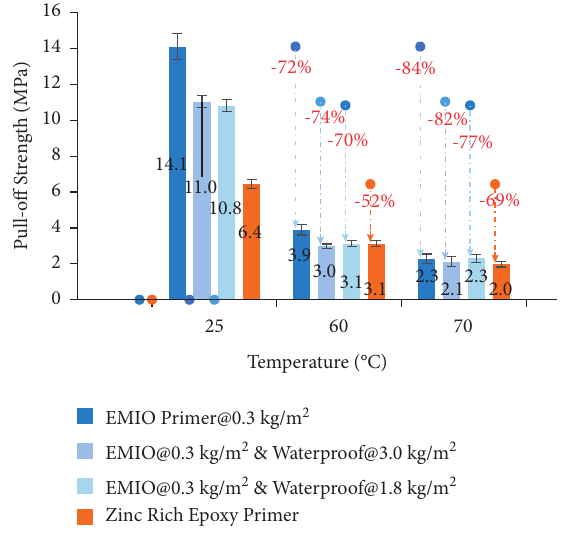
Figure 3: Pull-off strength test results.